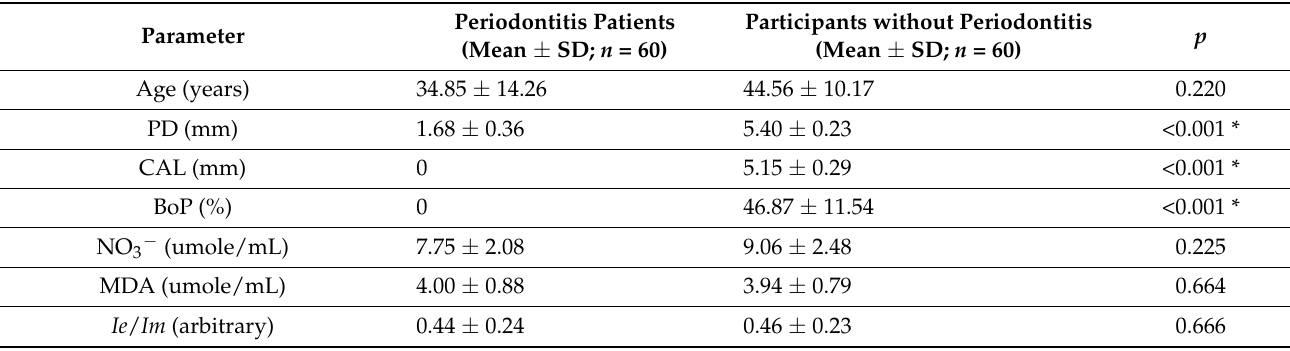
Table 1. Clinical parameters and markers of oxidative stress in the 2 groups.